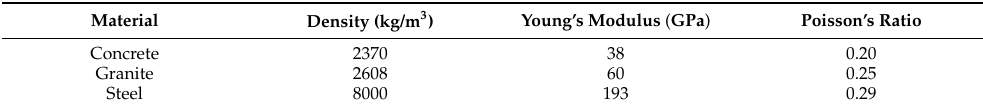
Table 5. Mechanical properties of concrete, granite, and